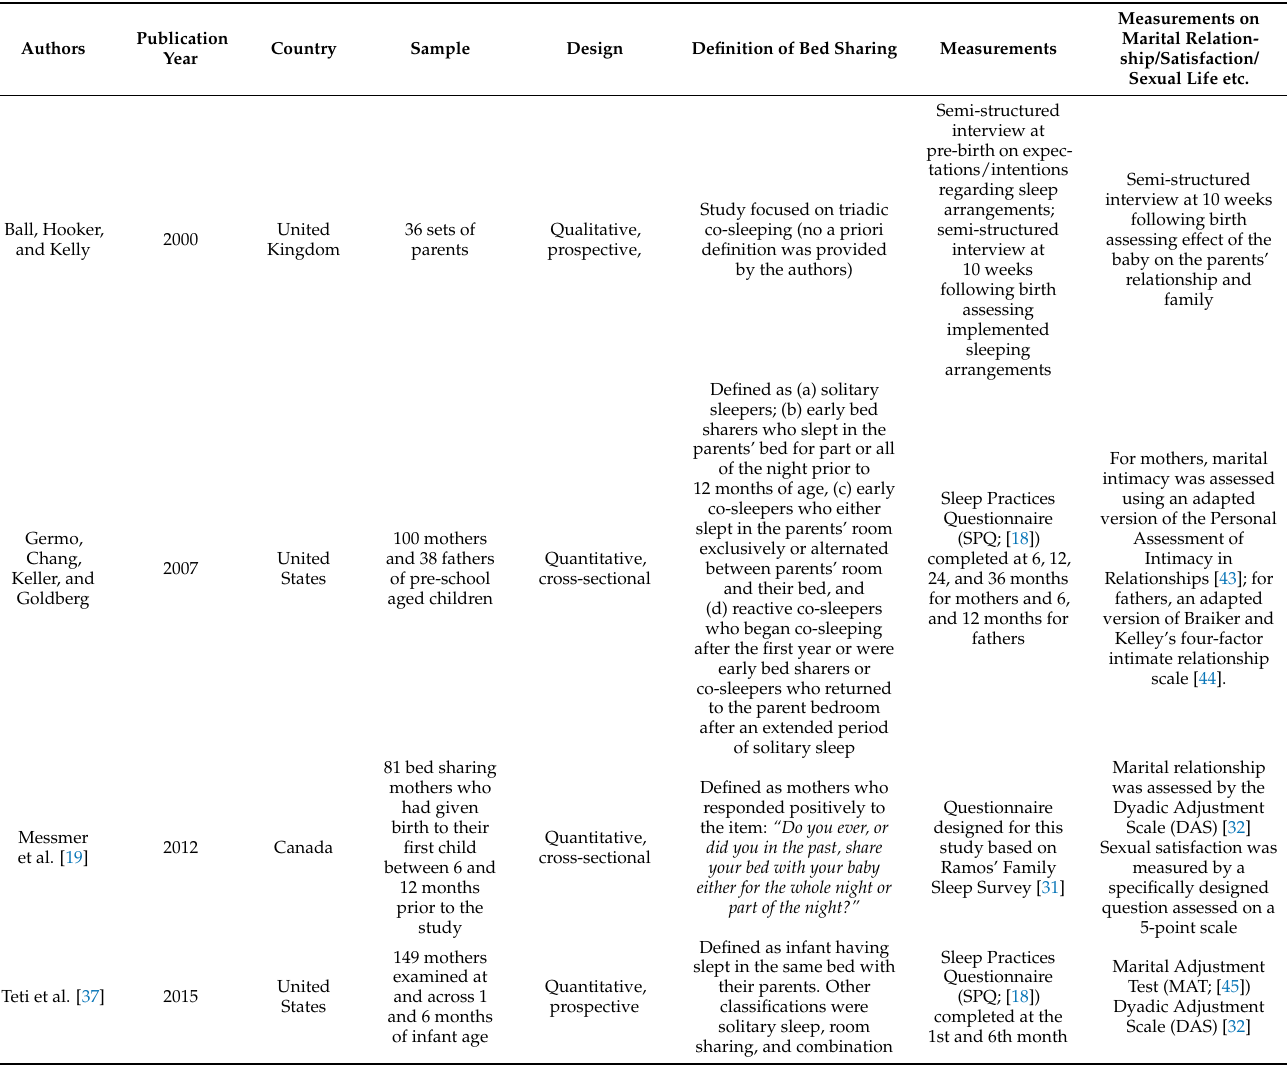
Table A1. Characteristics of included